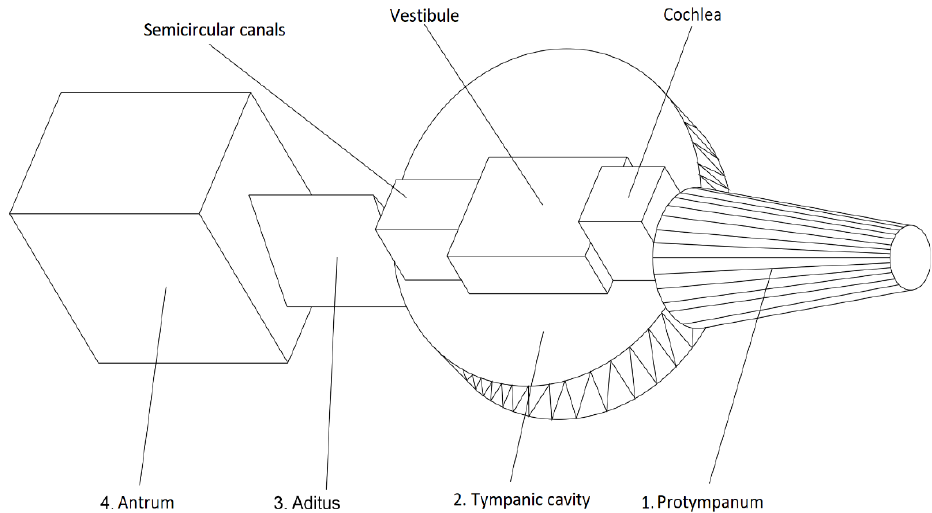
Figure 2. Three-dimensional representation of the fixed geometry middle-ear and inner-ear according to the geometric model of the temporal bone.